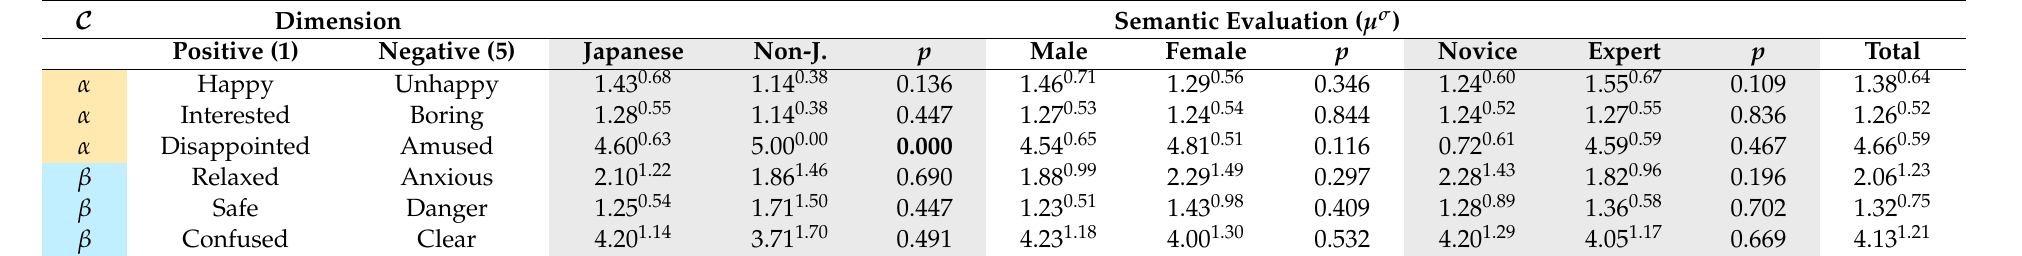
Table 2. Semantic analysis results (K-1), about the feelings the participant had regarding the robot. The concepts ( C ) are regarding to the satisfaction ( α ) and comfort ( β ).